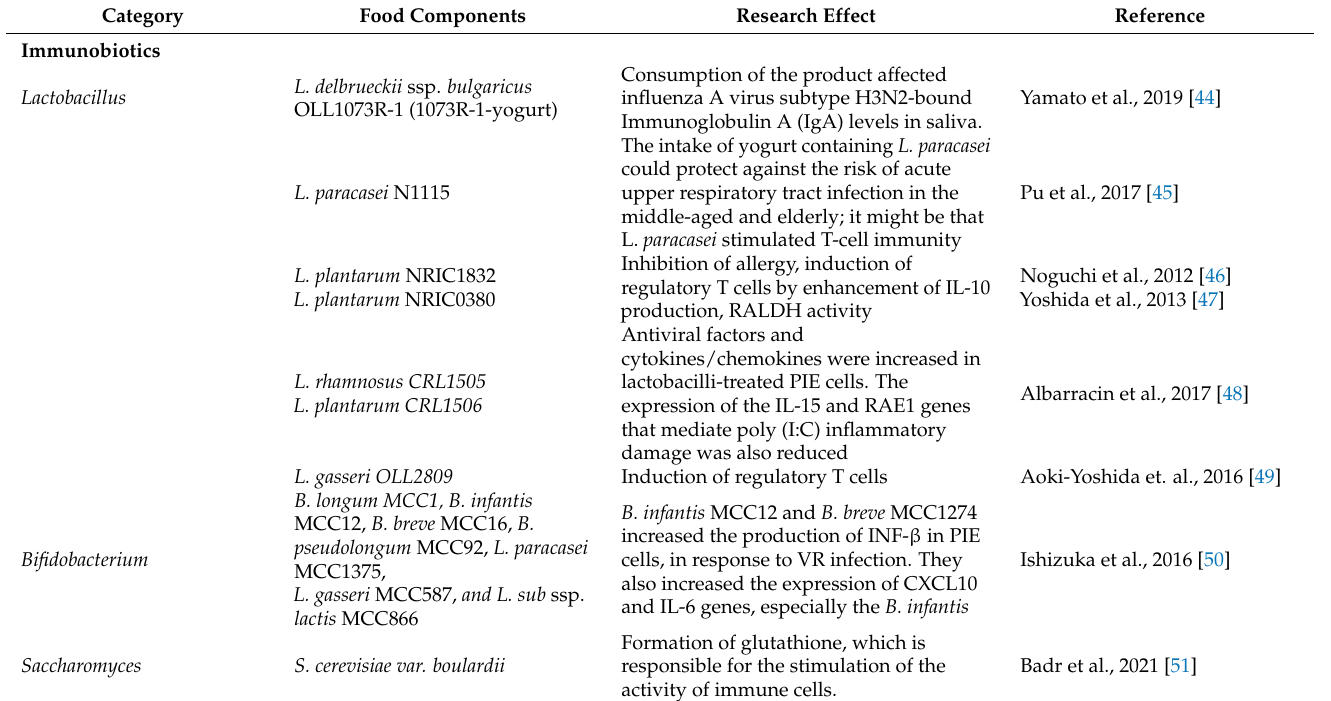
Table 1. Effect of immunomodulation by selected